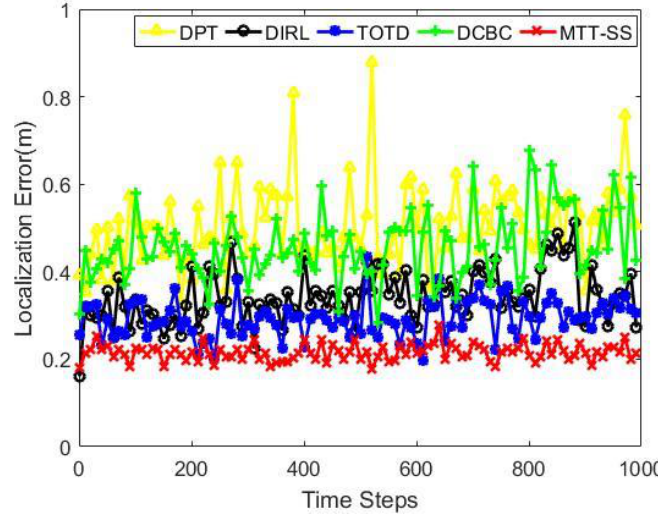
Figure 5. Localization error. Table 2. Standard deviation of localization errors.